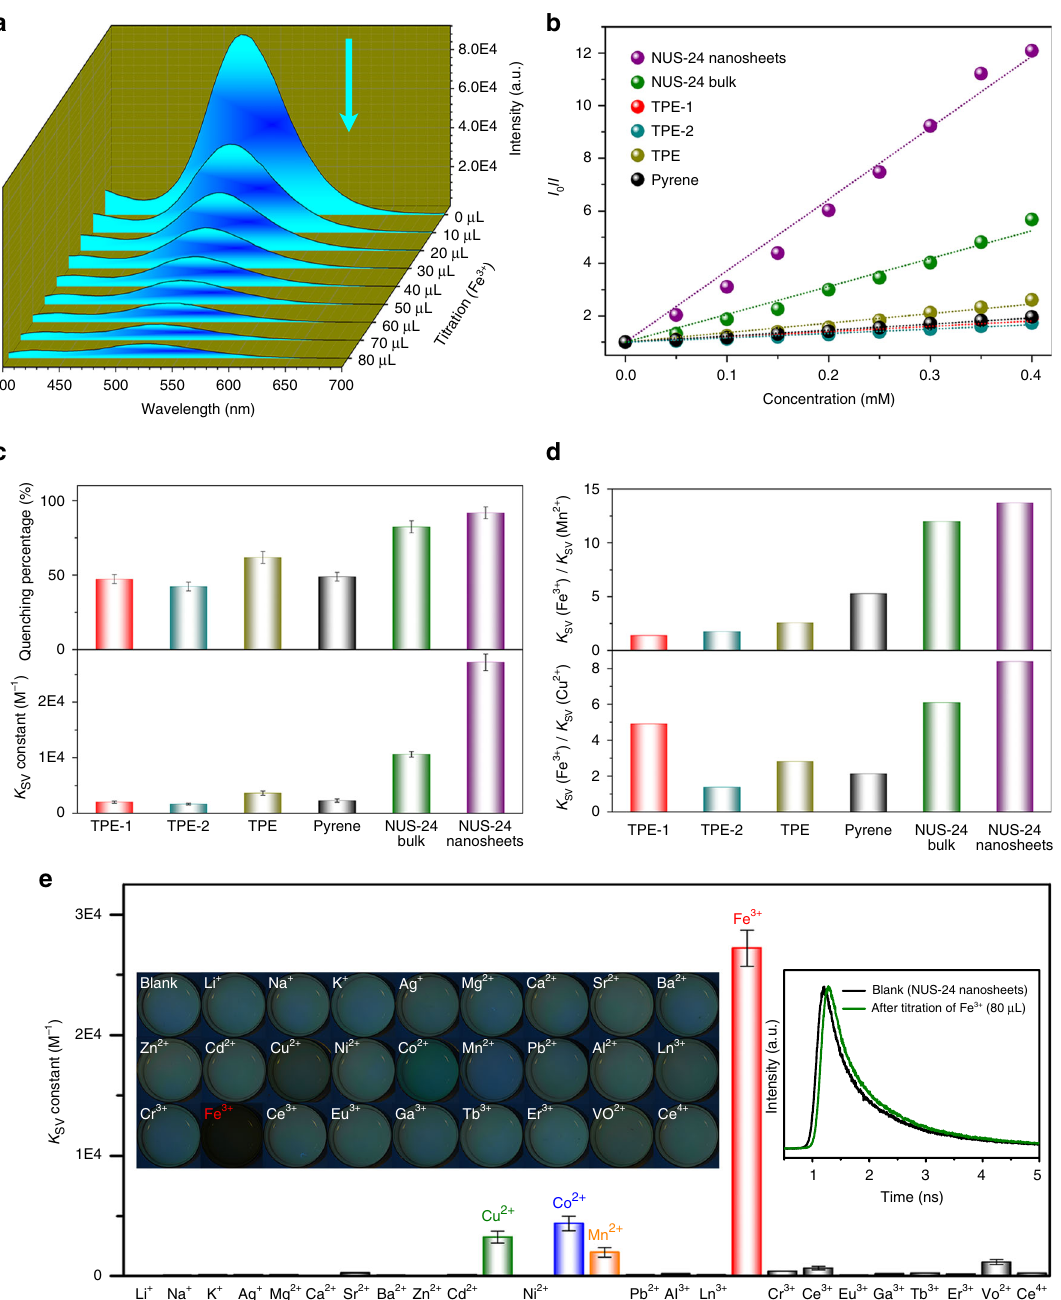
Fig. 5 Chemical sensing of metal ions by NUS-24 nanosheets. a Fluorescence emission spectra of NUS-24 nanosheets ( c = 0.1 mg mL − 1 ) upon titration with Fe 3+ solution (1 × 10 − 2 M) at room temperature ( λ ex = 365 nm). b Stern − Völmer plots of NUS-24 nanosheets, bulk powder, and compared small molecules being titrated with Fe 3+ . c The quenching percentages and K sv constants of NUS-24 nanosheets, bulk powder, and compared small molecules by Fe 3+ . d The ion selectivity of NUS-24 nanosheets, bulk powder, and compared small molecules. e The K SV constants of NUS-24 nanosheets being titrated with different metal ion solutions (left inset: fl uorescent photograph of NUS-24 nanosheets upon titration with different metal ion solutions, λ ex = 365 nm; Right inset: emission decay trace of NUS-24 nanosheets before and after the addition of Fe 3+ solution at room temperature). The error bars in c and e show average and range of measured values based on at least fi ve repeats in every single